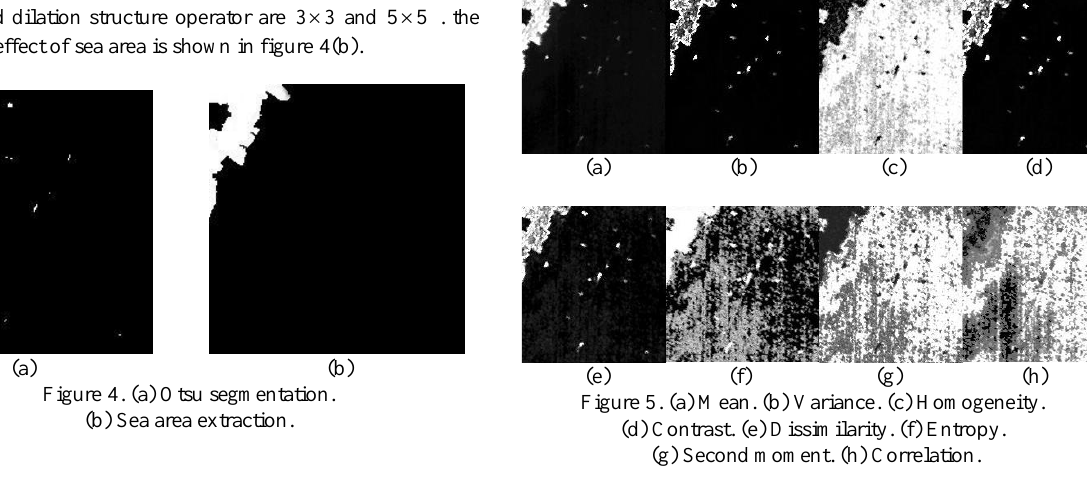
A total of 32 texture feature vectors are computed from the first PC of the image using a 3×3 window with direction 0 45 90 135 ， ， ， . Figure 5 (a ~ h) show 8 texture feature vectors in direction 45 . (a) Mean reflects the regularity of image texture. (b) Variance measures the deviation between the gray value and the mean value of each pixel. (c) Homogeneity measures whether the local change of image texture is uniform. (d) Contrast reflects the local change information of the image. (e) Dissimilarity is similar to contrast, but linear increase. (f) Entropy measures the amount of information contained in the image. (g) Second moment reflects the distribution of image Figure 3. (a)Three-band colour composite of the image. grayscale. (h) Correlation reflects the similarity between (b) Gray scale image of the 51st band. adjacent pixels in the horizontal and vertical direction.